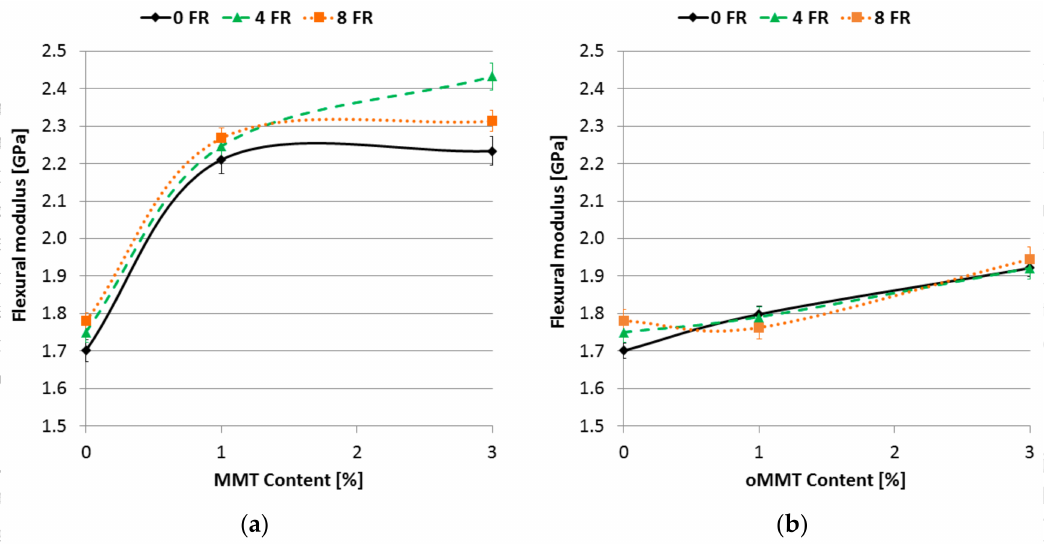
Figure 12. Flexural modulus as a function of filler content: ( a ) MMT filler; ( b ) oMMT